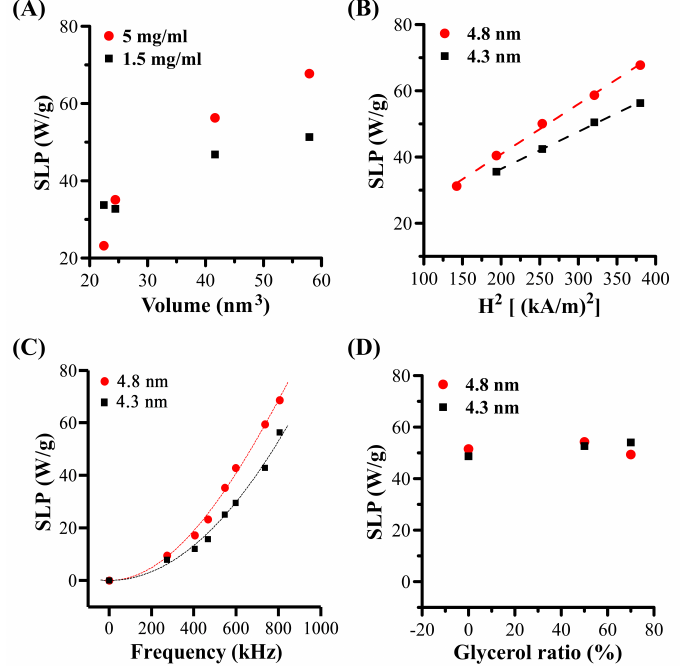
Figure 7. The Special Loss Power (SLP) vs. di ff erent factors. ( A ) SLP vs. MHFn particles volume. Measurements were performed at H = 19.5 kA / m and f = 805.5 kHz. ( B ) SLP vs. amplitude. Measurements were performed at c (4.8 nm) = c (4.3 nm) = 5 mg[Fe] / mL, f = 805.5 kHz. Dotted lines were linear fitting with SLP = a f H 2 + b. ( C ) SLP vs. frequency. Measurements were performed at c (4.8 nm) = c (4.3 nm) = 5 mg[Fe] / mL, H = 19.5 kA / m. Lines were represent fits results of equation (1). ( D ) SLP vs. glycerol ratio. Measurements were performed at c (4.8 nm) = 1.5 mg[Fe] / mL, c (4.3 nm) = 2.5 mg[Fe] / mL, H = 19.5 kA / m and f = 805.5